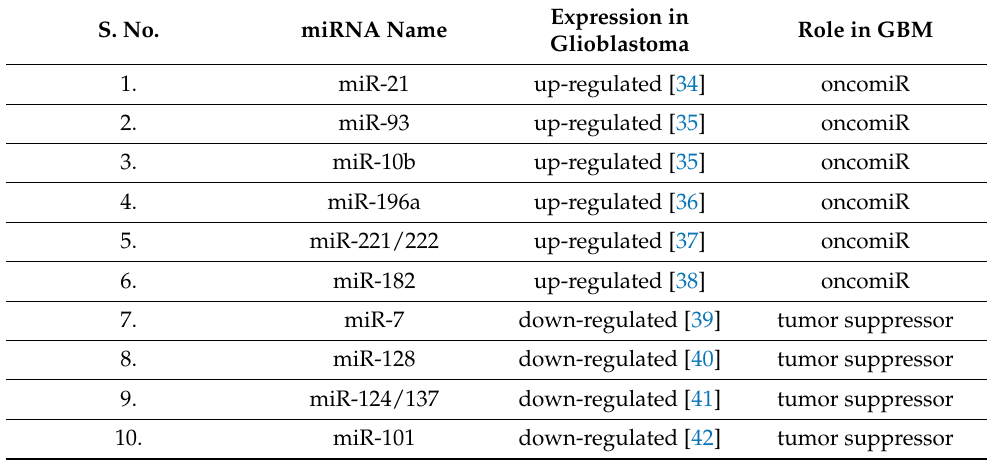
Table 1. miRNAs with both suppressor and oncogenic functions in glioblastoma multiforme. S.